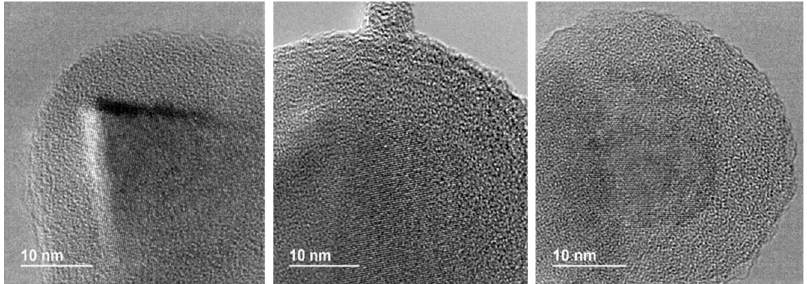
Figure 4. Representative HR-TEM images of the Al 2 O 3 @SiC core–shell nanoparticles (scale-up synthesis).